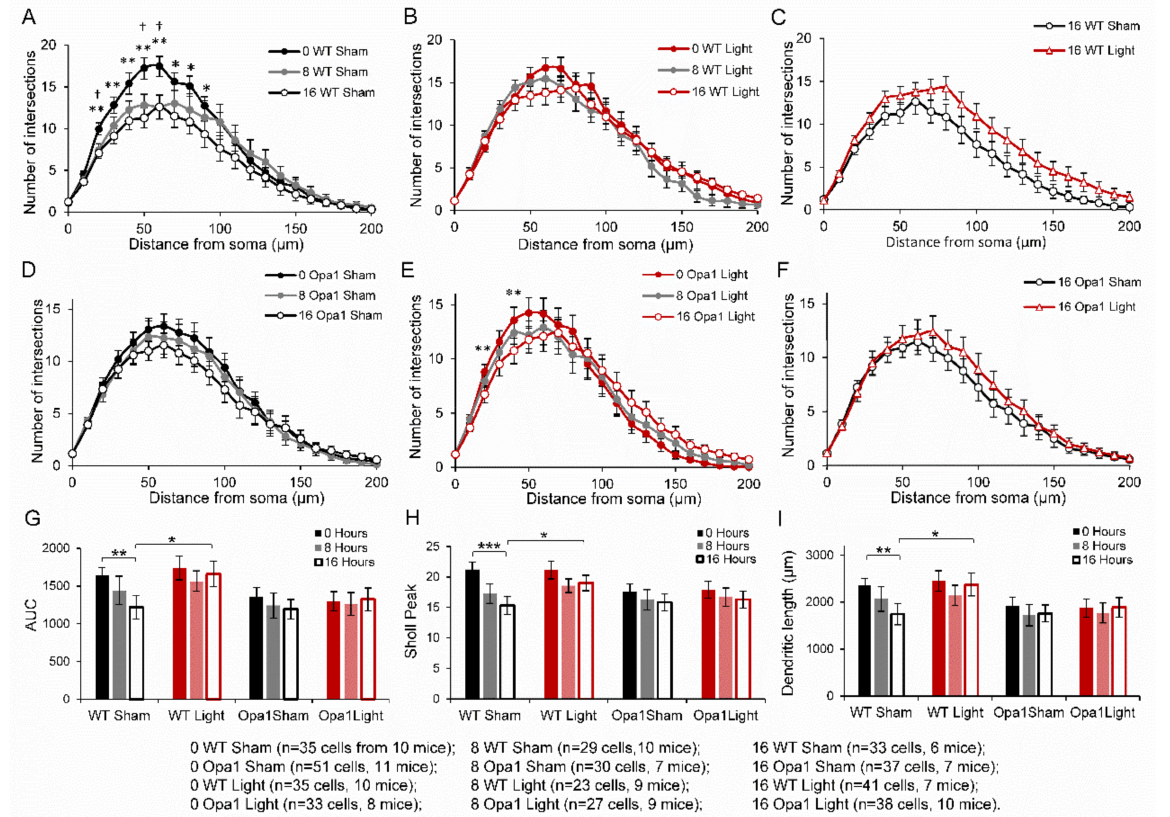
Figure 2. In vivo 670 nm pretreatment inhibited the axotomy-related dendropathy that occurred in sham-treated WT over 16 h following axotomy. Sholl profiles of ( A ) sham-treated aged WT RGCs showed significant degeneration over time post axotomy. ( B ) no effects were observed in light-treated WT RGCs. ( C ) Direct comparison of sham vs. light treatment following 16 h ex vivo. WT RGCs; ( D ) Sham- and ( E ) light-treated Opa1 +/ − RGC Sholl curves showed no significant degeneration ex vivo. ( F ) a direct comparison of the two 16-h Opa1 +/ − groups showed no significant effects. RGC dendritic complexity was also quantified by ( G ) the area under the Sholl curve (AUC); ( H ) average maximum peak of Sholl curve; and ( I ) average total dendritic length. All measures revealed significant degeneration over 16 h in the sham-treated WT RGCs, which was inhibited by the light treatment, as shown by the 16-h WT light group having significantly greater dendritic complexity. Daggers and stars indicate a statistically significant reduction in the number of dendritic intersections from 0 h to 8- and 16-h, respectively. * p < 0.05, ** p < 0.01, *** p < 0.001, † p < 0.05; Mann-Whitney U -test. Error bars represent